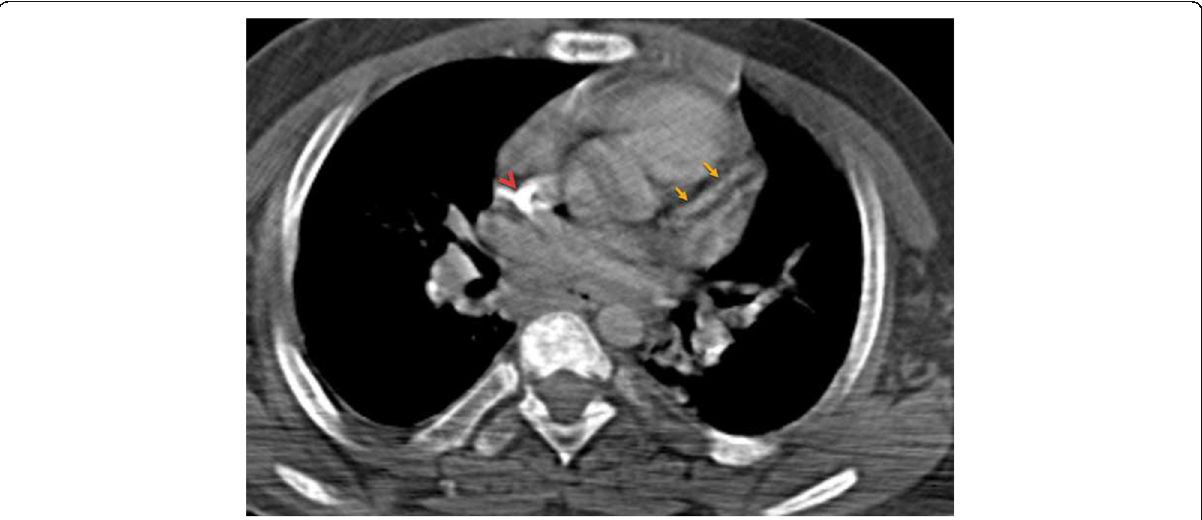
Fig. 1 The un-enhanced chest CT image obtained 3 years ago shows a chronic calcified thrombus (arrowhead) in the superior vena cava. Left anterior descending (LAD) coronary artery (arrows) is normal, and no calcific atherosclerotic plaque is